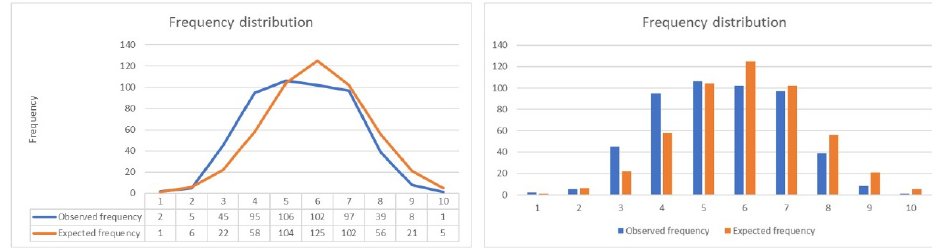
Figure 1. The practice of Team 1 of prospective teachers (G1) on Activity 1 (Retrieved from [37]). The prospective teachers of Team 1 observed that the closer they came to the center of the target the fewer the arrows, and that this made sense as it was an amateur tournament. They also noted that the target rings with the fewest arrows are Ring One and Ring Ten, whereas Rings Five and Six have the most arrows. They also indicated that data ranging from Ring One to Ring Five (in that order) have increasing behavior, while data ranging from Ring Six to Ring Ten (in that order) have decreasing behavior. Besides, they made two frequency distribution graphs, from the observed (OF) and expected (EF) frequencies provided in the problem. From the trends they visualized in the graphs, they referred to “OF is similar to EF,” “the shapes of the graphs are bell-shaped,” and “it seems that OF has greater dispersion than EF.” Finally, the teachers of Team 1 guessed that the observed data indeed follow a normal distribution.